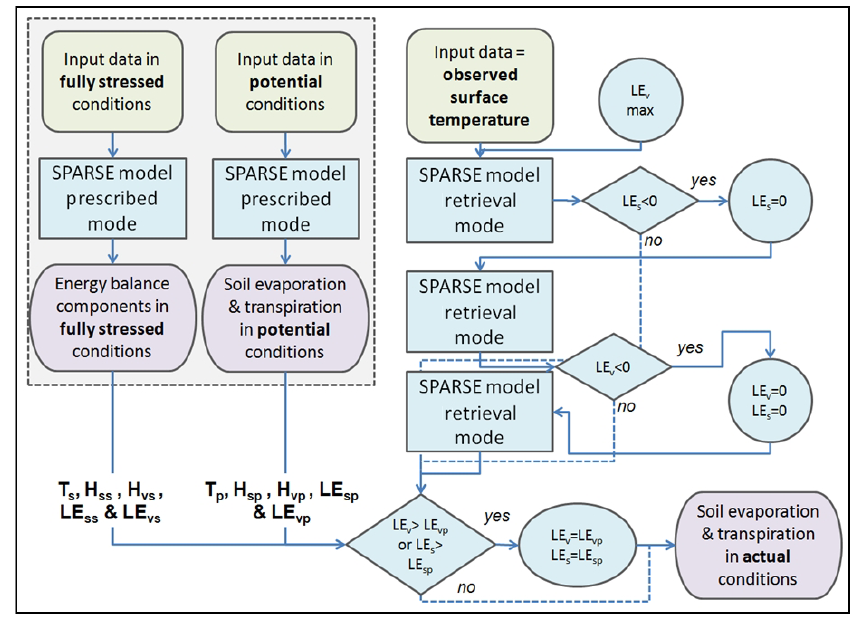
Figure 5. Flowchart of the SPARSE algorithm; T s , H ss , H vs , LE ss and LE vs are surface temperature, soil sensible heat flux, vegetation sensible heat flux, soil latent heat flux and vegetation latent heat flux in fully stressed conditions, respectively; T p , H sp , H vp , LE sp and LE vp are surface temperature, soil sensible heat flux, vegetation sensible heat flux, soil latent heat flux and vegetation latent heat flux in potential conditions,